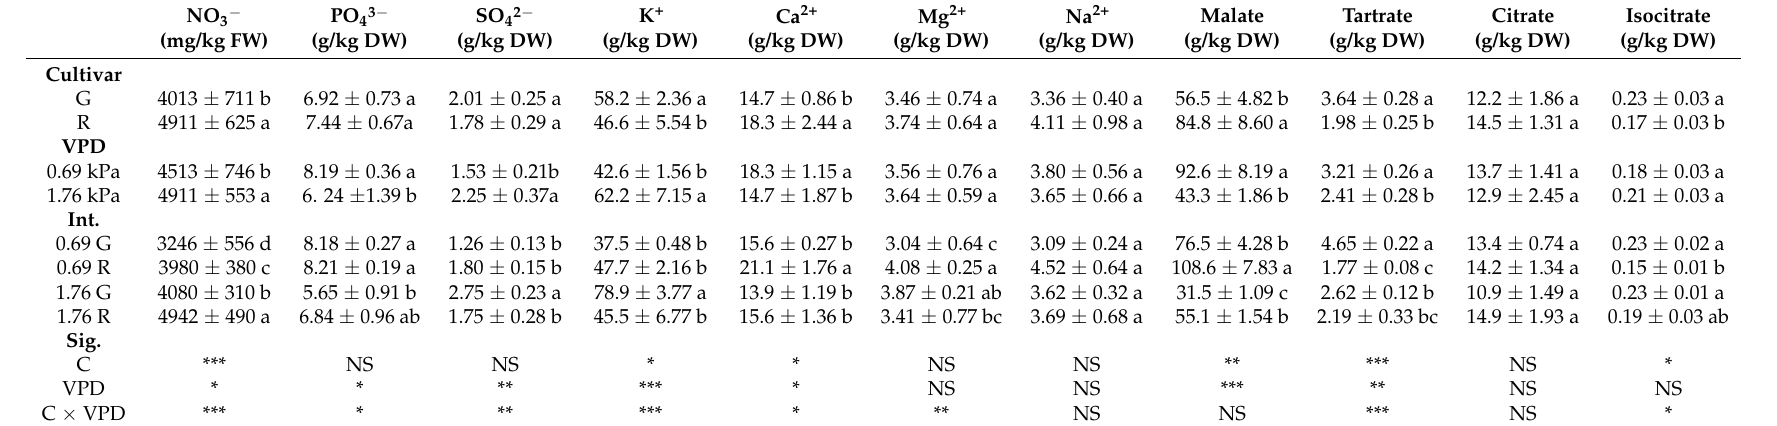
Table 3. Minerals in leaves of green (G) and red (R) lettuce plants grown under the two VPD levels (0.69 and 1.76